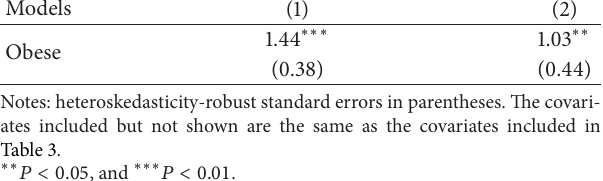
Table 3. ∗∗ 𝑃 < 0.05 , and ∗∗∗ 𝑃 < 0.01